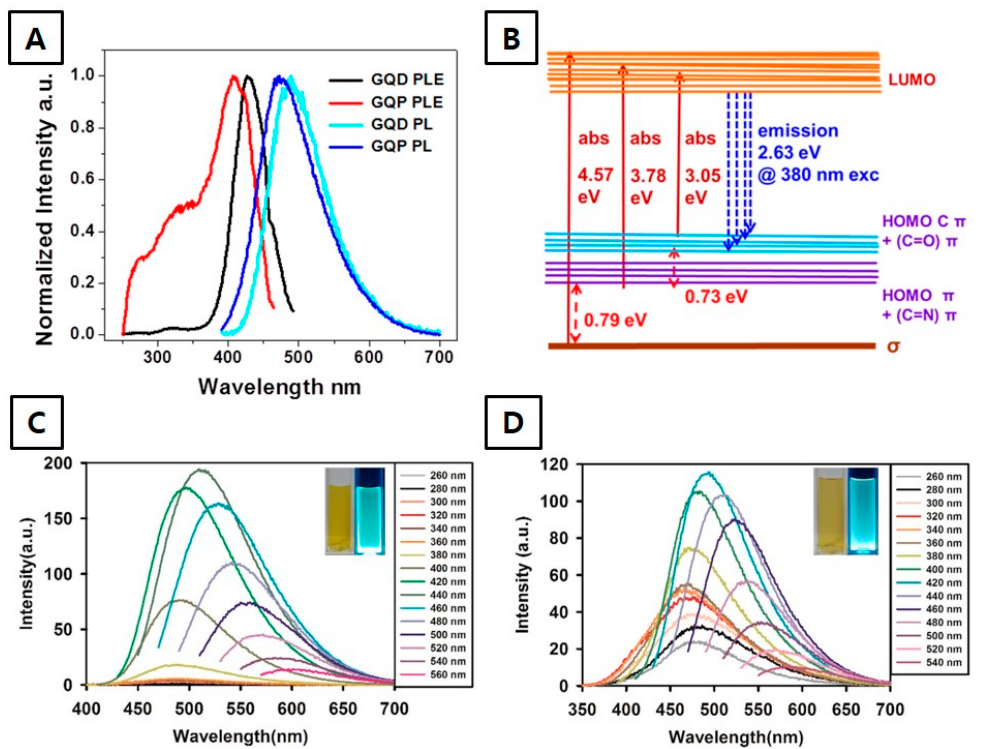
Figure 4. ( A ) Normalized photoluminescence emission (PL), photoluminescence excitation (PLE) spectra of GQPs and GQDs. ( B ) Optical transition for GQPs and typical Fluorescence spectra of obtained ( C ) GQDs and ( D ) GQPs (Inset: Under visible (left) and under 365 nm UV radiation